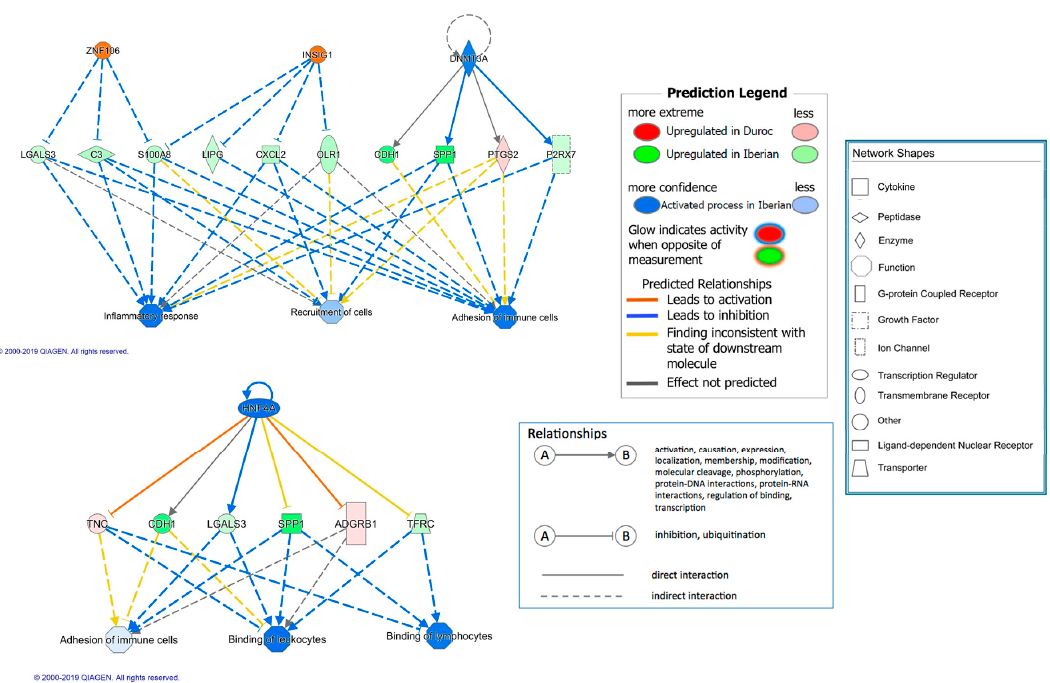
Figure 1. Regulator effects networks predicted as activated in Iberian pigs.